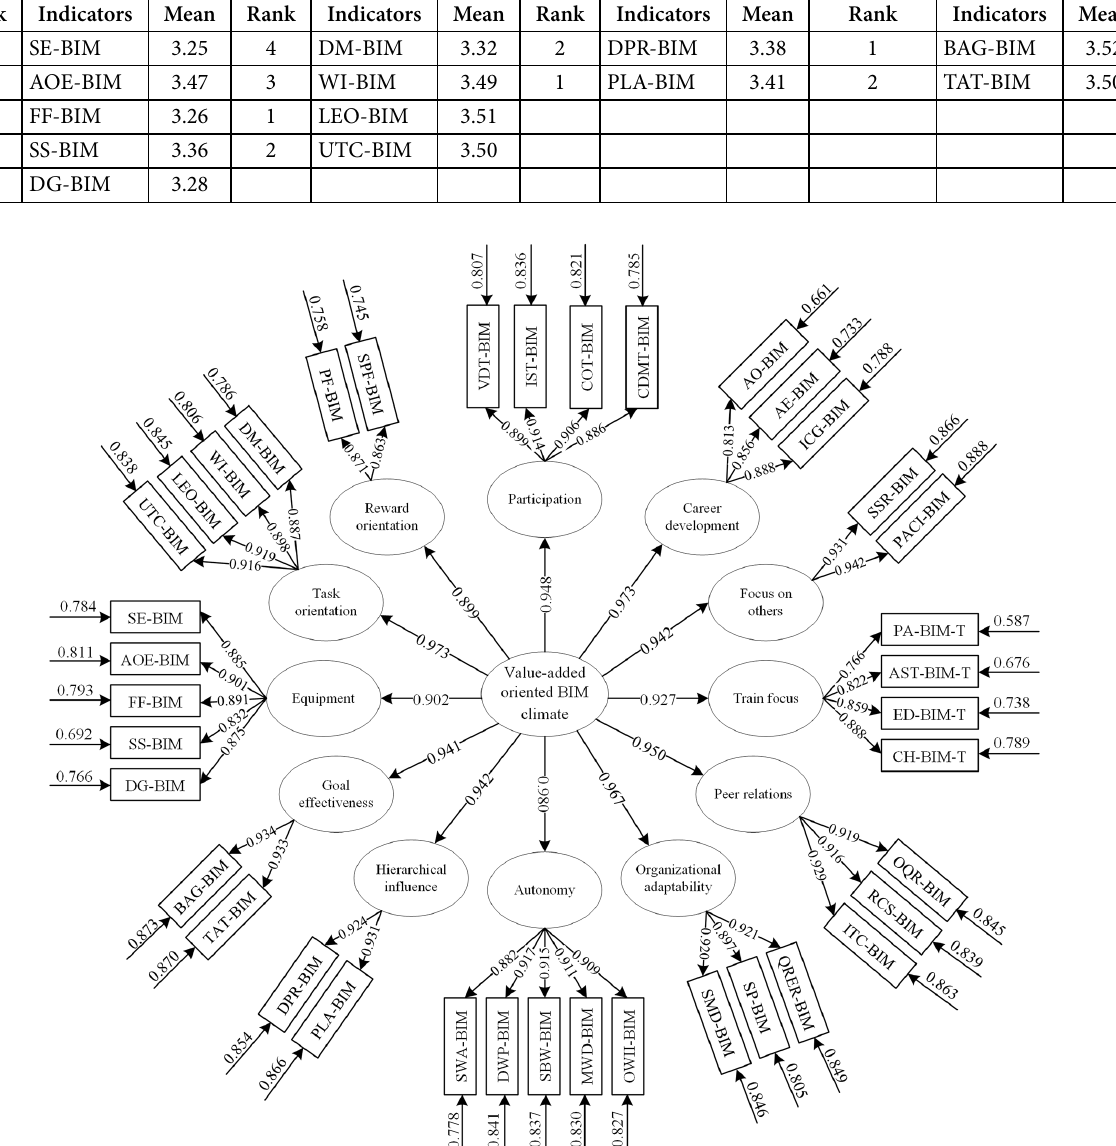
Figure 3. Results of